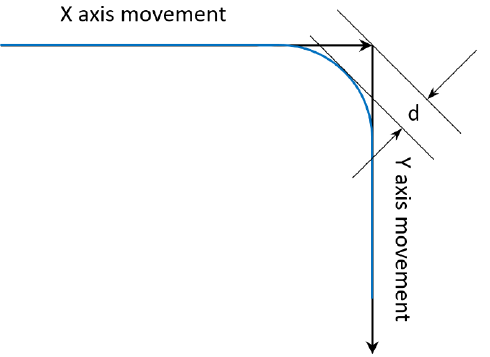
Figure 5. Deviation of the deposition path when approaching a straight corner in the LMD